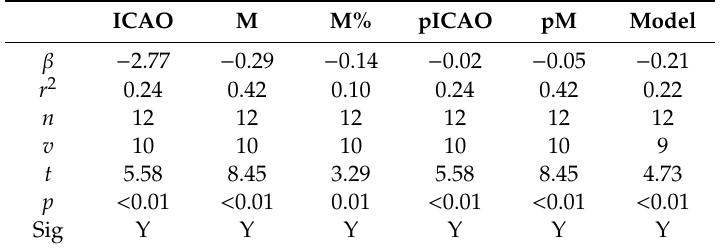
Table 3. Correlation and regression test results for the various longitudinal factors.